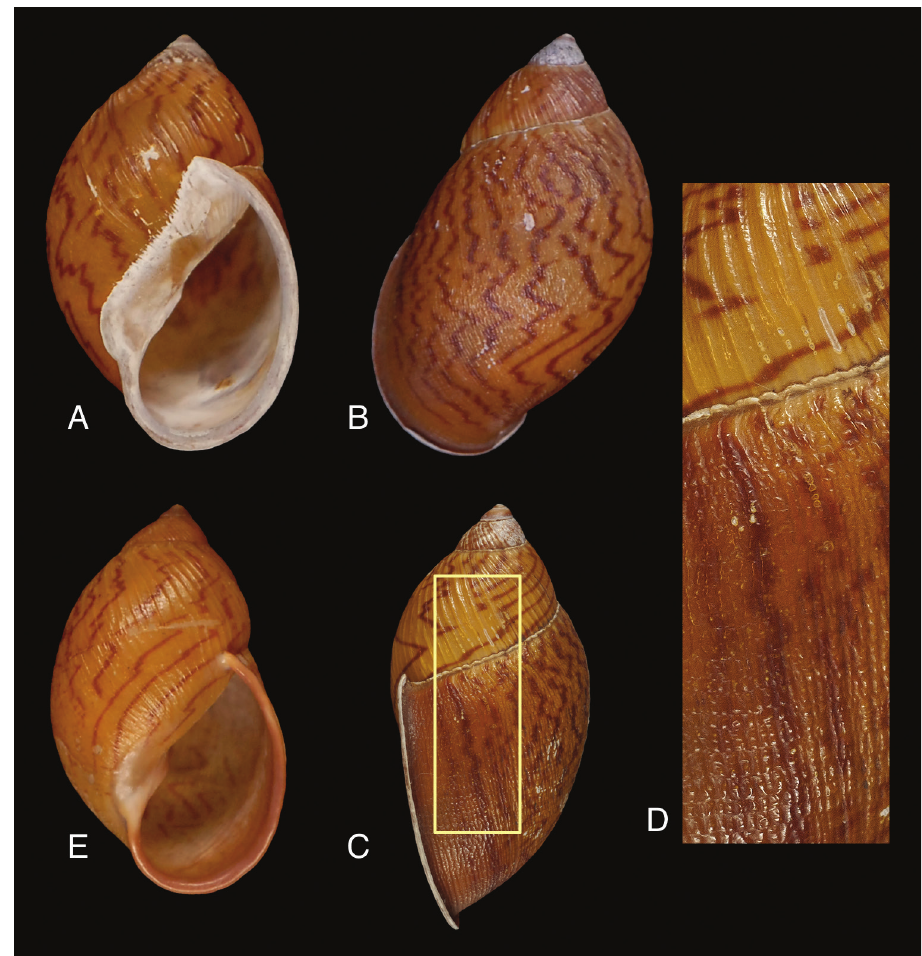
Figure 2. Plekocheilus ( Plekocheilus ) cecepeus sp. n., A–D holotype MNCN 15.05/60013H (H = 44.8) E paratype MNCN 15.05/60013P (H =